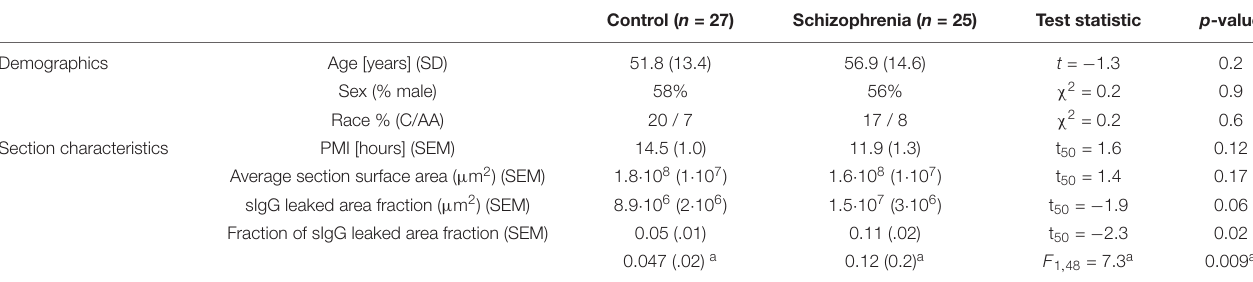
TABLE 1 | Post-mortem tissue sample demographics and section